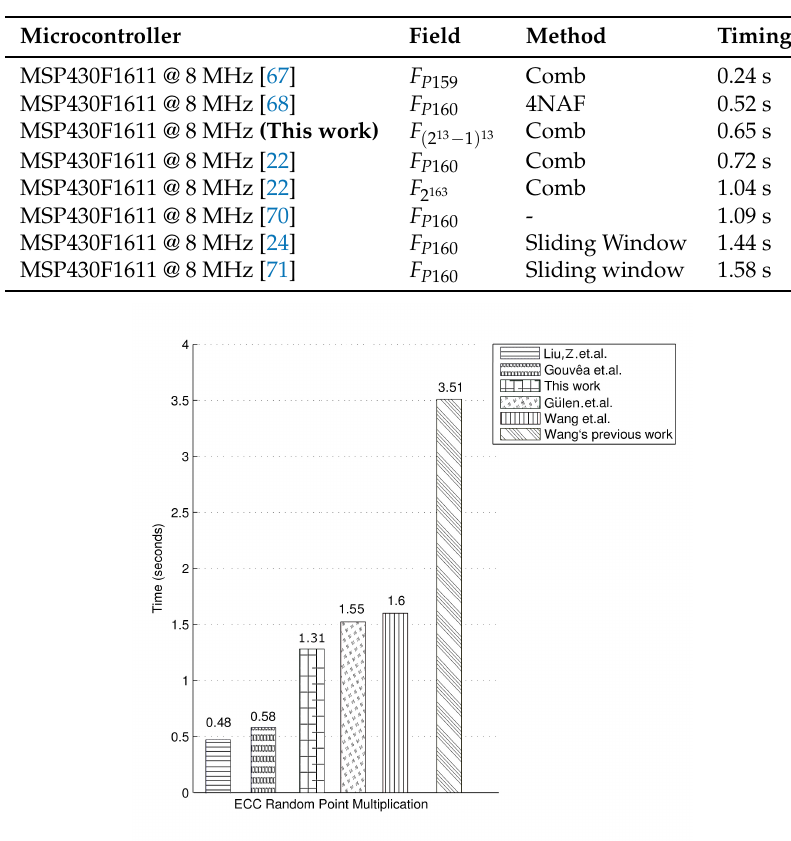
Table 3. Timings for ECC fixed point multiplication.